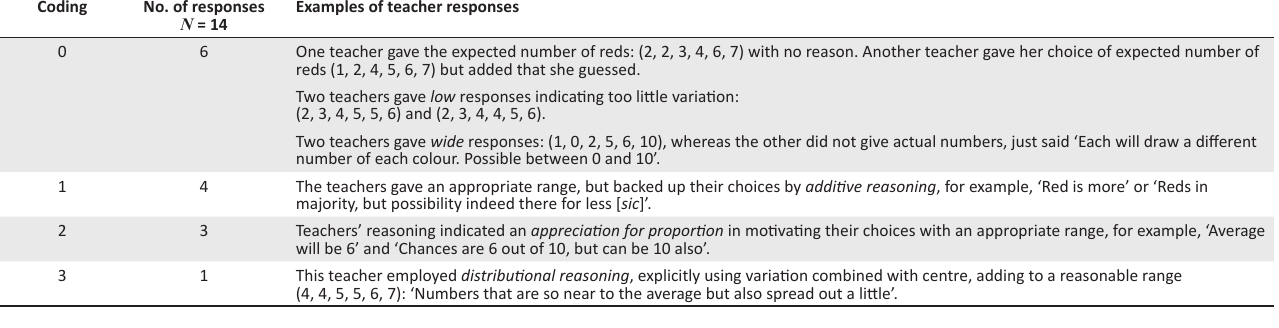
TABLE 5: Summary of responses to Question 3: ‘Write down the number of reds that you think each classmate might get. Why did you choose these numbers?’ Coding